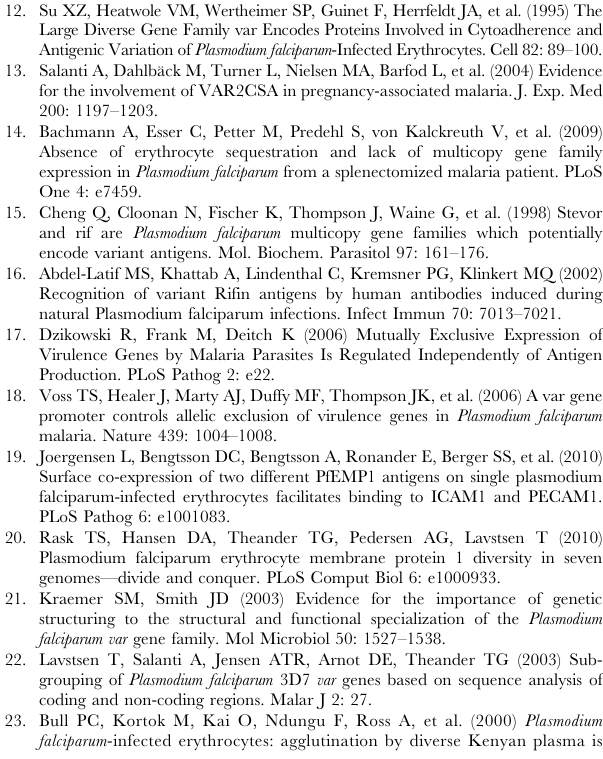
Table S1 Overview of the 54 volunteers involved. Table S2 Primers used for Plasmodium falciparum antigen